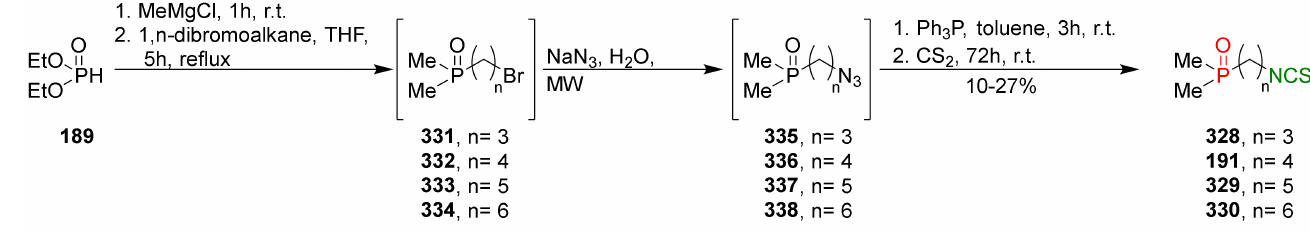
Figure 39. Synthesis of ( ω -isothiocyanatoalkyl)dimethylphosphine oxides 191 and 328 – 330 .